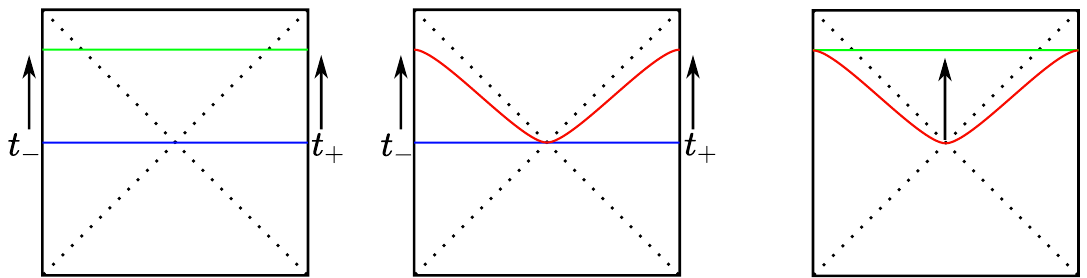
Figure 1 . Different kinds of bulk time evolution in the AdS-Schwarzschild geometry (figure adapted from [31]). The ADM Hamiltonians H move the boundary edges of a bulk Cauchy slice up and ± down, as in the left two diagrams, but the evolution of the interior of the slice, as in going from the red slice to the green slice in the right diagram, is generated by the Hamiltonian constraint and thus is trivial on gauge-invariant